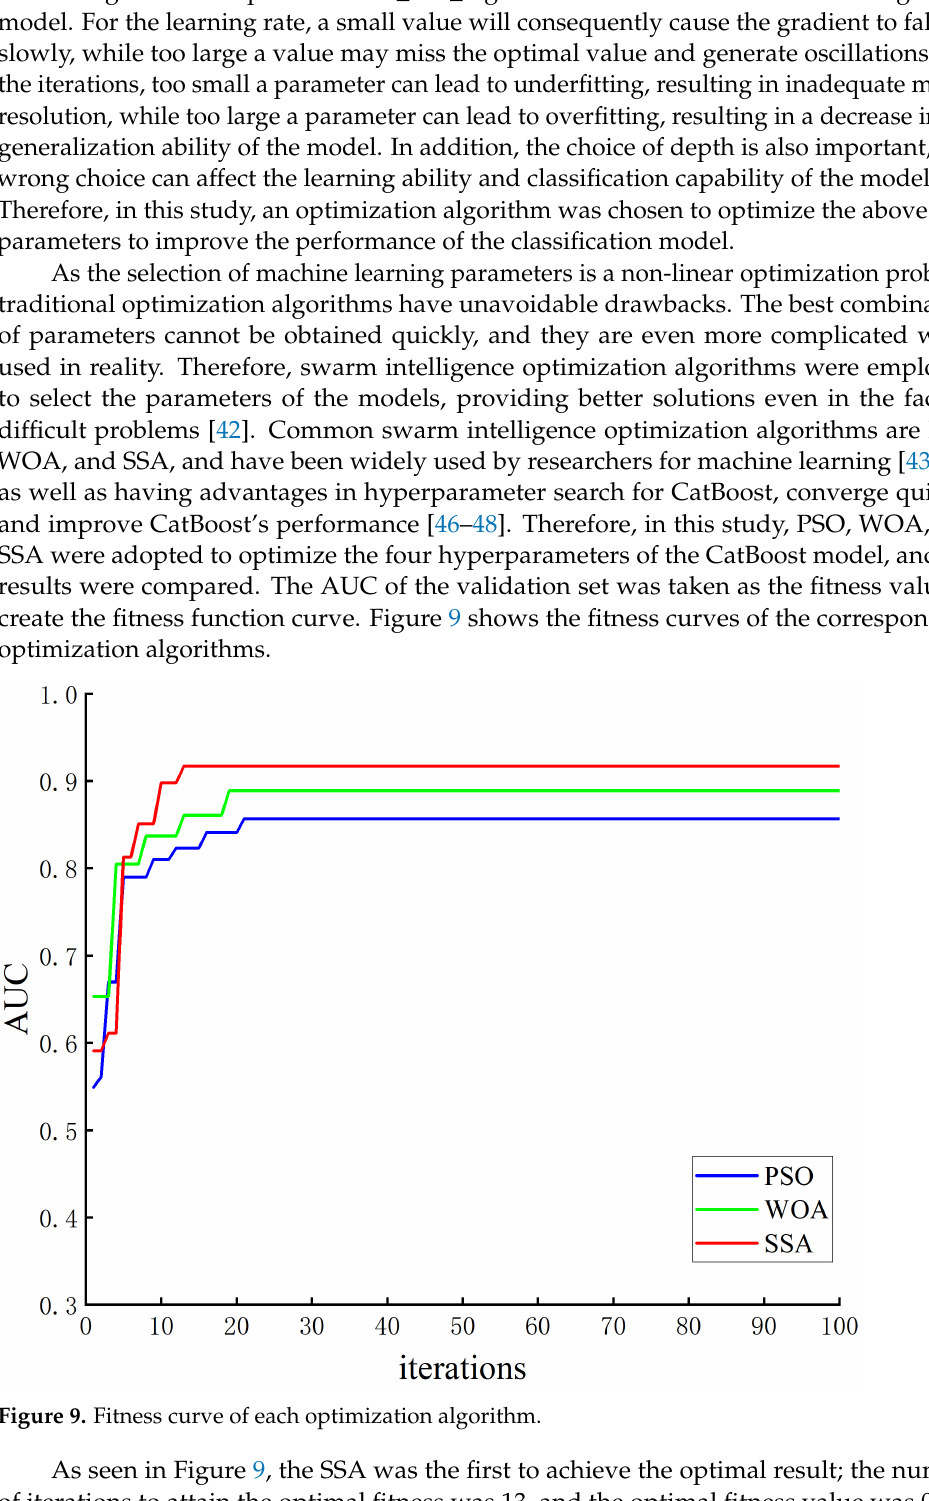
Table 10. Optimal parameters of CatBoost for different optimization algorithms. Optimization Algorithm Optimal Parameters for CatBoost PSO